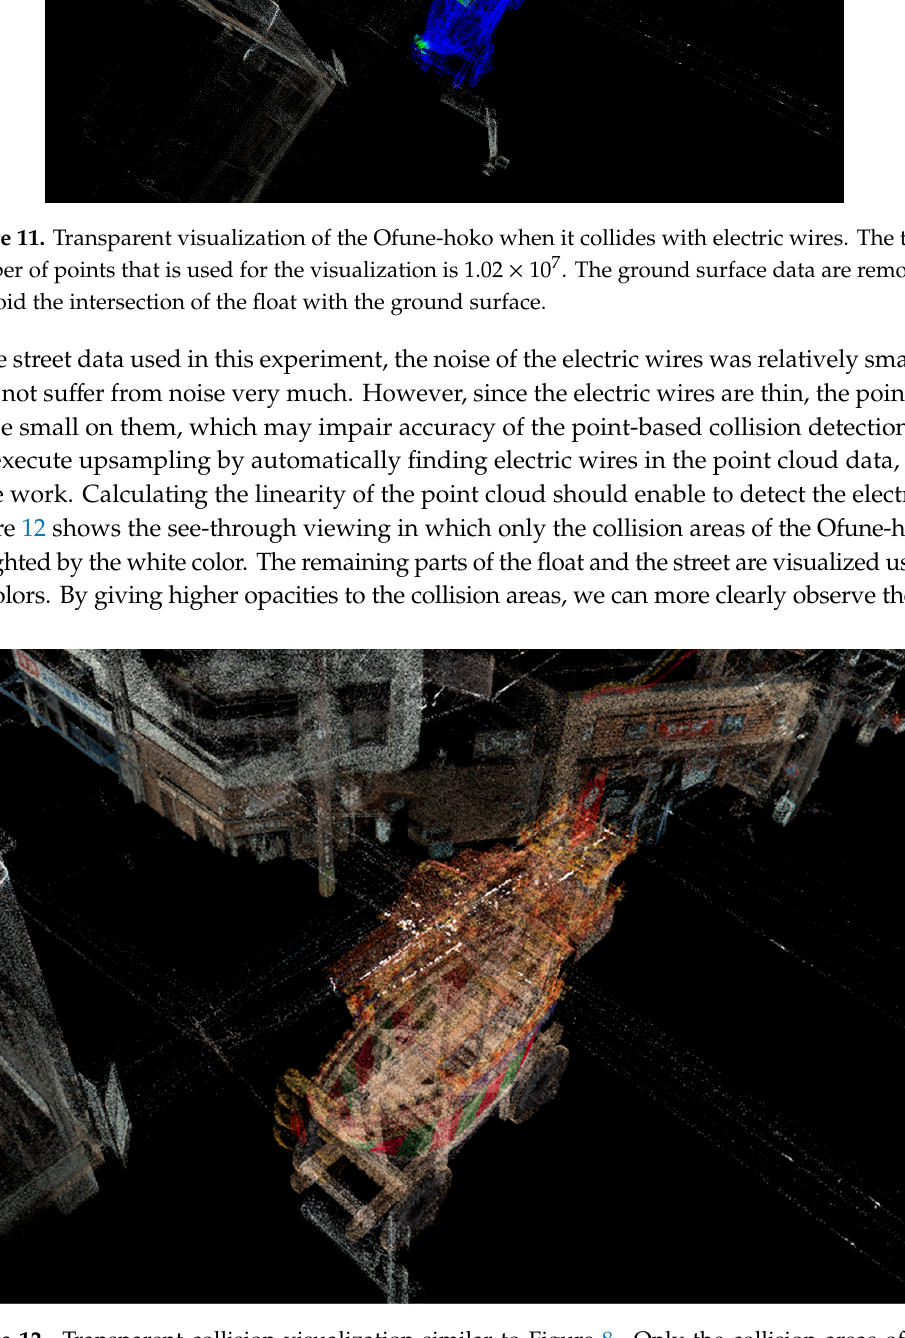
( b ) Figure 13. Visualization results of the Ofune-hoko float: ( a ) Transparent collision visualization of the Ofune-hoko float without showing the point cloud of the street, and ( b ) only the collision areas of the float are highlighted in white.